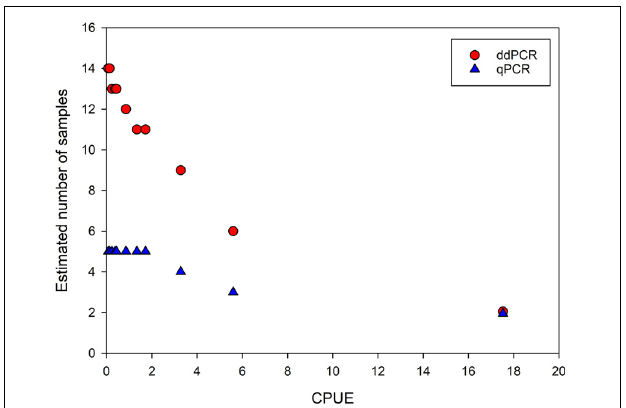
FIGURE 7 | Estimated number of water samples needed to achieve 95% detection likelihood at different relative densities of crayfish (CPUE) for qPCR and ddPCR.